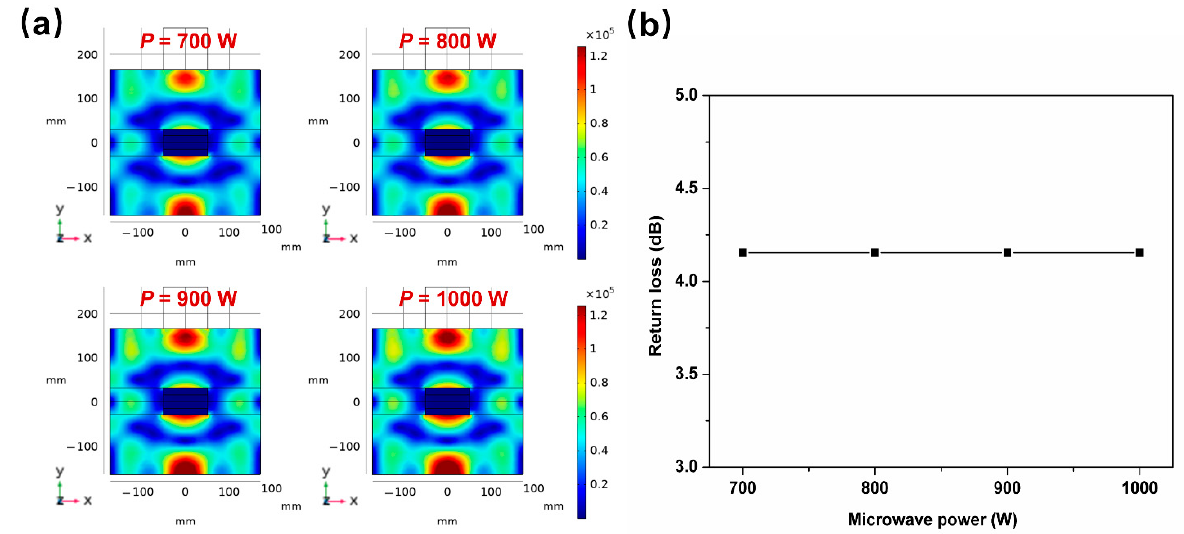
Figure 5. Effect of microwave power on the simulated electric fields (the electric field unit: V/m; x– y plane, z = 0; z i = 5 mm; l SiC = 100 mm; v = 0.02 m/s): ( a ) variation of the electric fields with different microwave power; and ( b ) the microwave return loss with different microwave power.